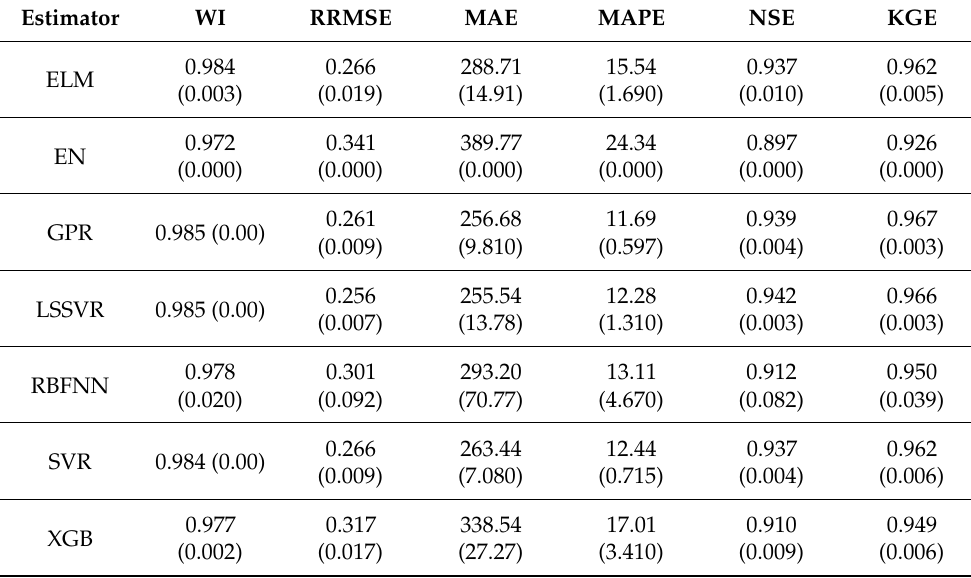
Table 13. Model results for Case